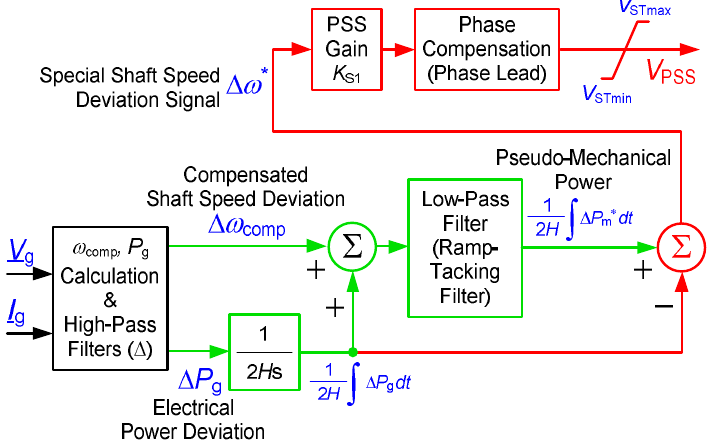
Figure 3. The algorithm of the dual-input PSS-P-ω stabilizer.